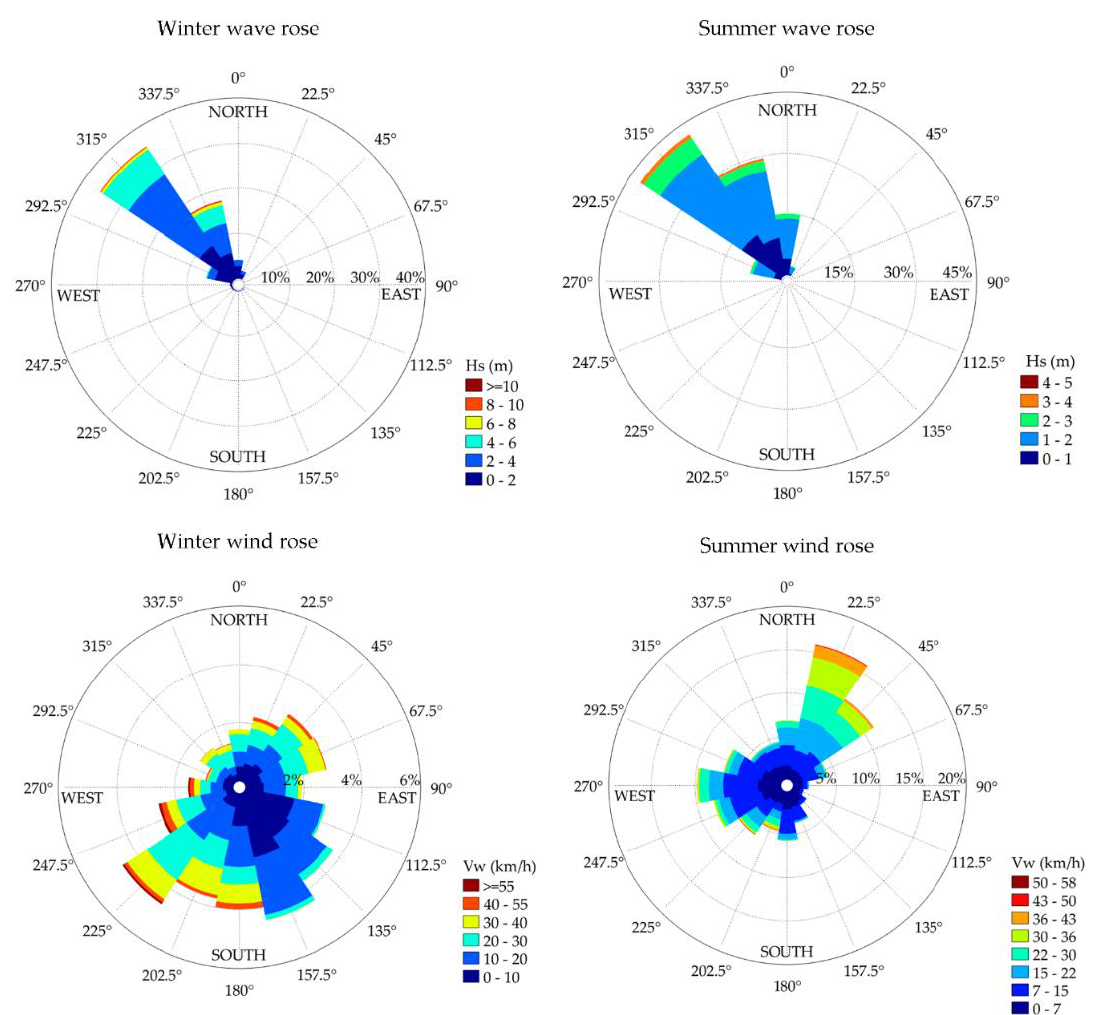
Figure 3. Seasonal wind and wave roses (winter and summer) at the buoy position for the period 2015 – 2018.